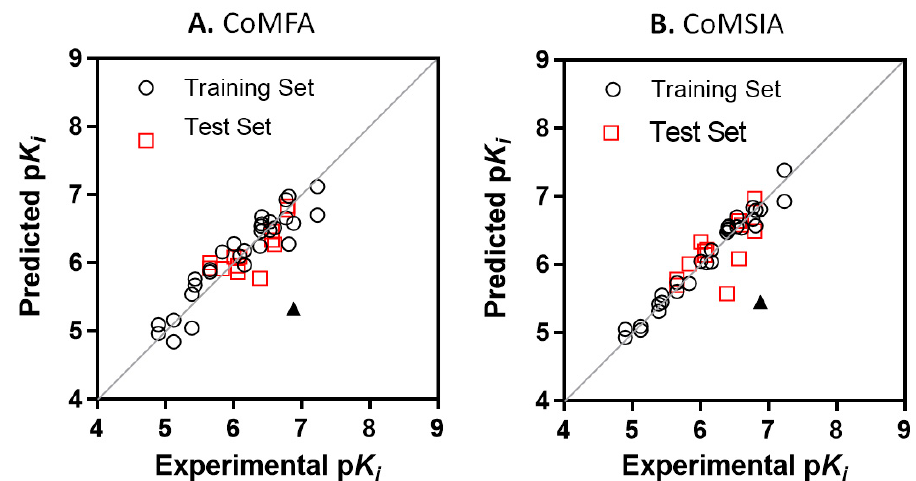
Figure 4 . Plots of experimental versus predicted p K i values for the training and test set molecules of ( A ) CoMFA and ( B ) CoMSIA. The only outlier compound (residual > 1.0) in both cases was compound 4s , represented as a triangle in the figure.